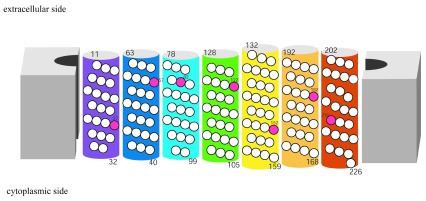
Schematic drawing of the 7TM bundle of MRs showing the proposed position of the *.50 residue in each helix (colored pink).The numbers attached to the helices are the selected ranges and the positions in the bR sequence.